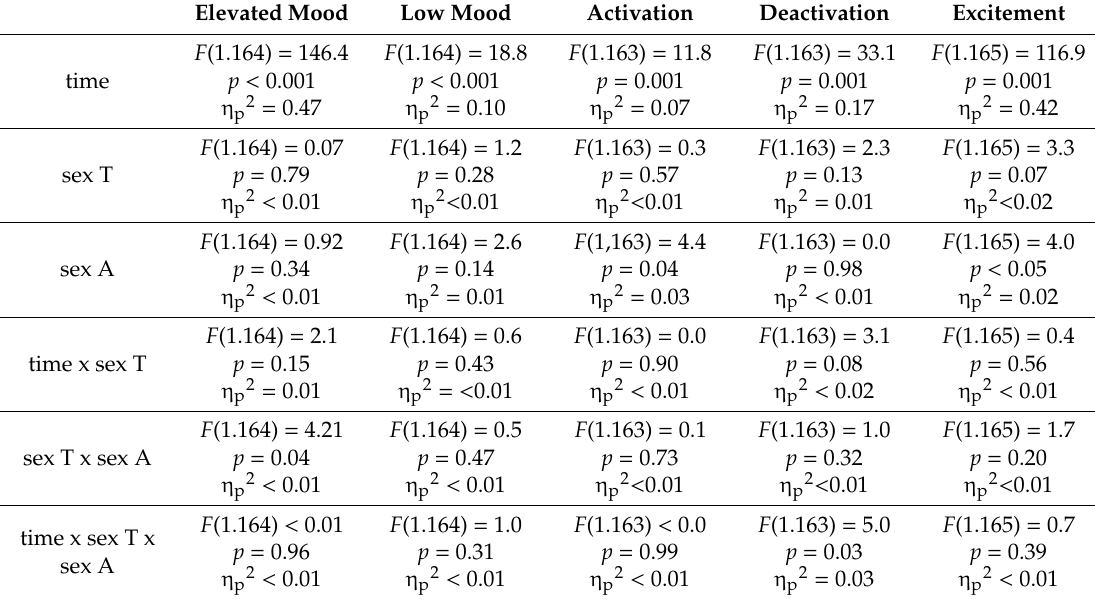
Table 4. Results of the mixed